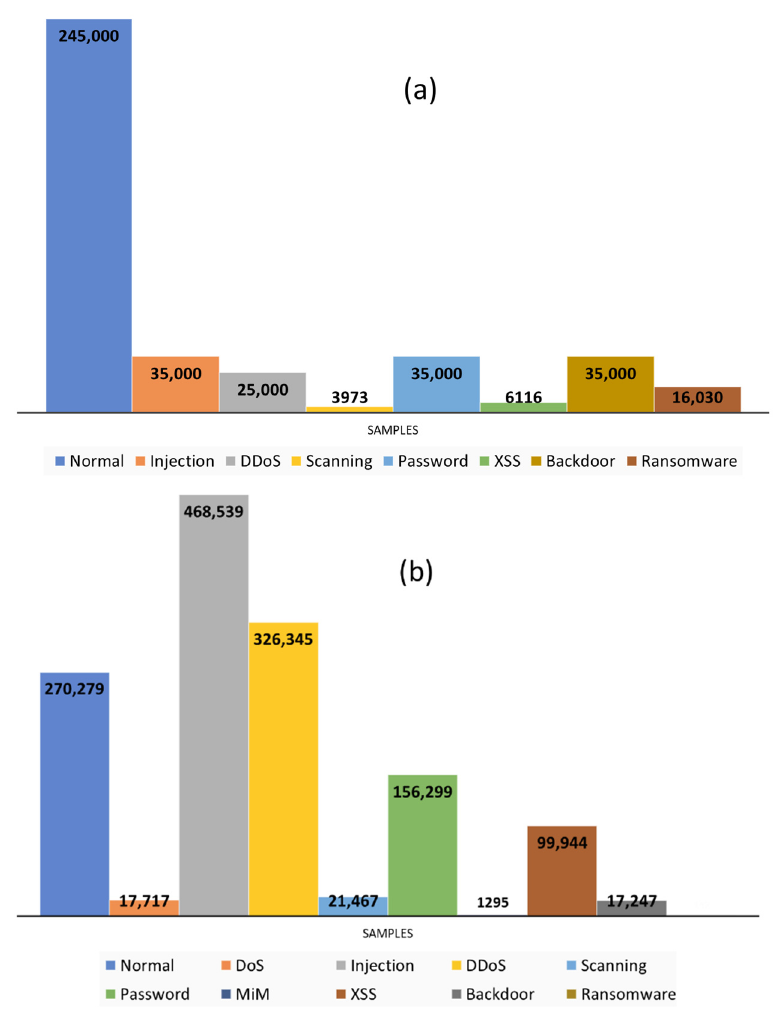
Figure 5. Number of attack samples in the sensor datasets ( a ) and NetFlow dataset ( b ).